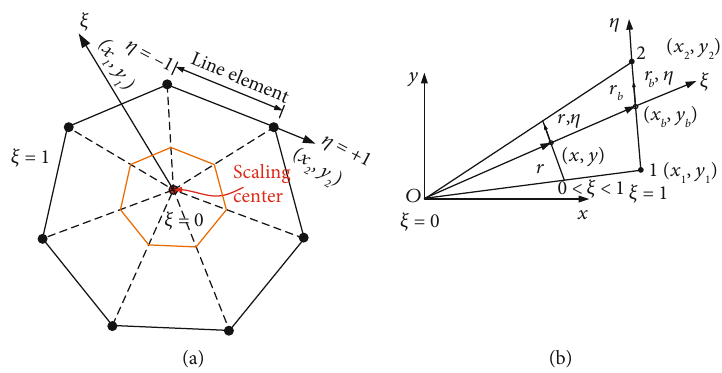
Figure 1: Coordinate system of the SBFEM: (a) S -element; (b) local coordinate system of the SBFEM.